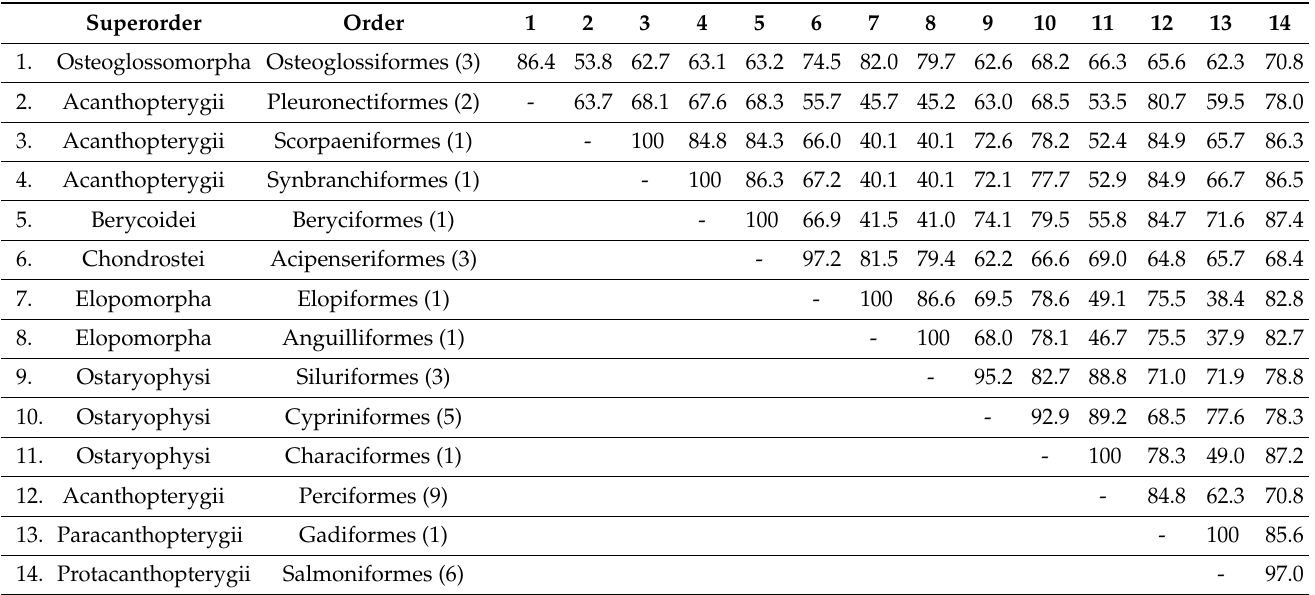
Table 3. Percentage identity of GH peptides between fish orders.